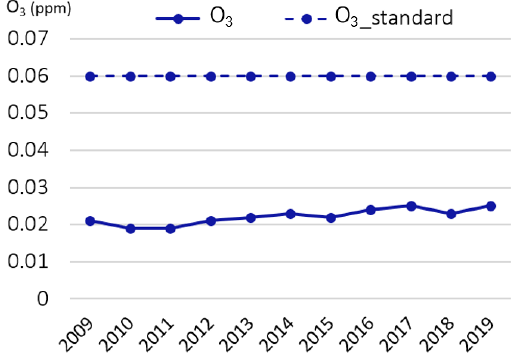
Figure 4. Concentration of O 3 .